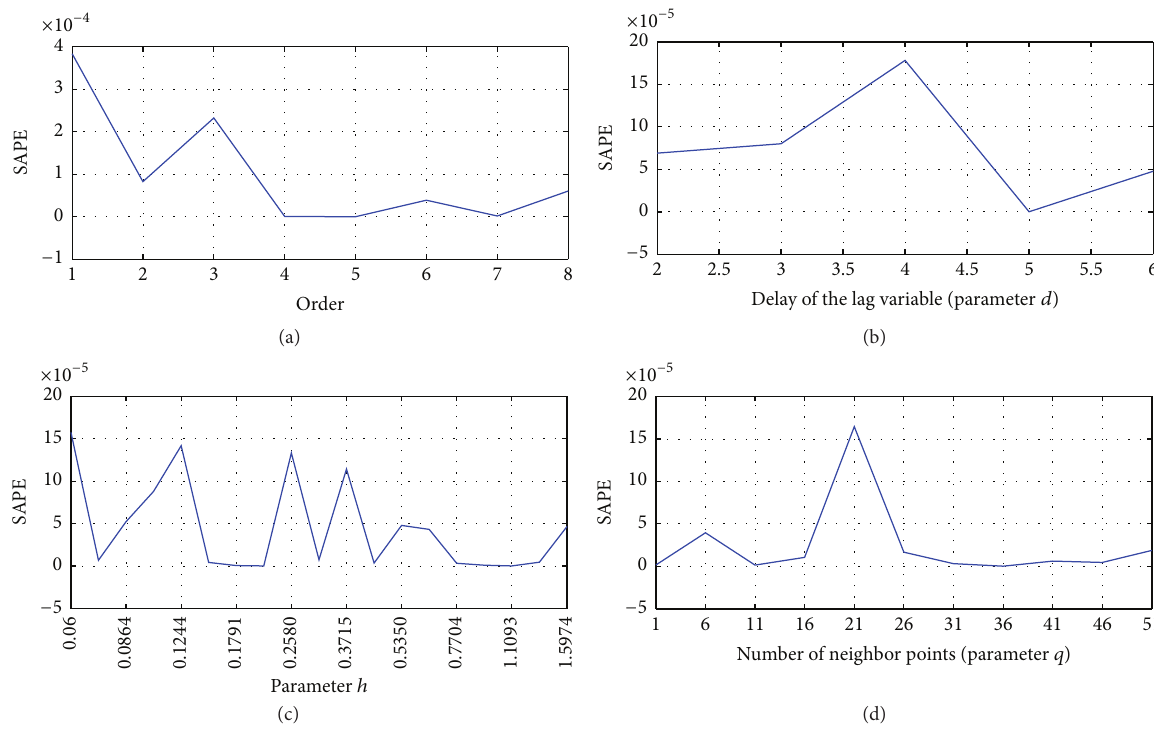
Figure 4: Results of Lorenz time series’ multistep prediction: (a) changed functional coefficients’ order; (b) changed delay of the lag variable; (c) changed number of nearest neighbor points; (d) changed radius of the